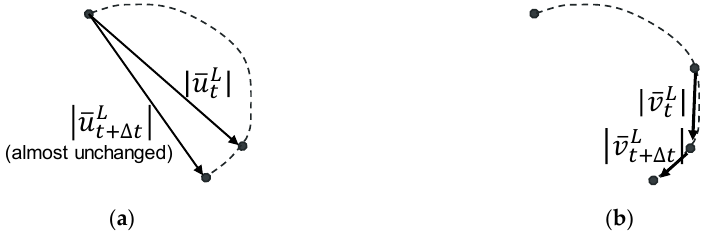
Figure 7. Displacement and velocity vectors of a moving point in image coordinate. The norm of the displacement vector does not represent the movement, making displacement an inappropriate indicator for synchronization. ( a ) Displacement vector history. ( b ) Velocity vector history.